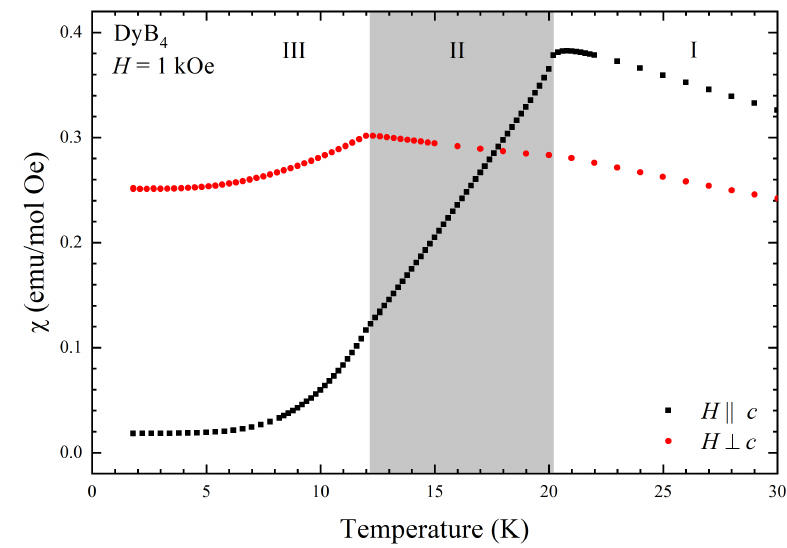
Figure 7. Temperature dependent magnetic susceptibility of DyB 4 in a field of 1 kOe for H (cid:107) c and H ⊥ c